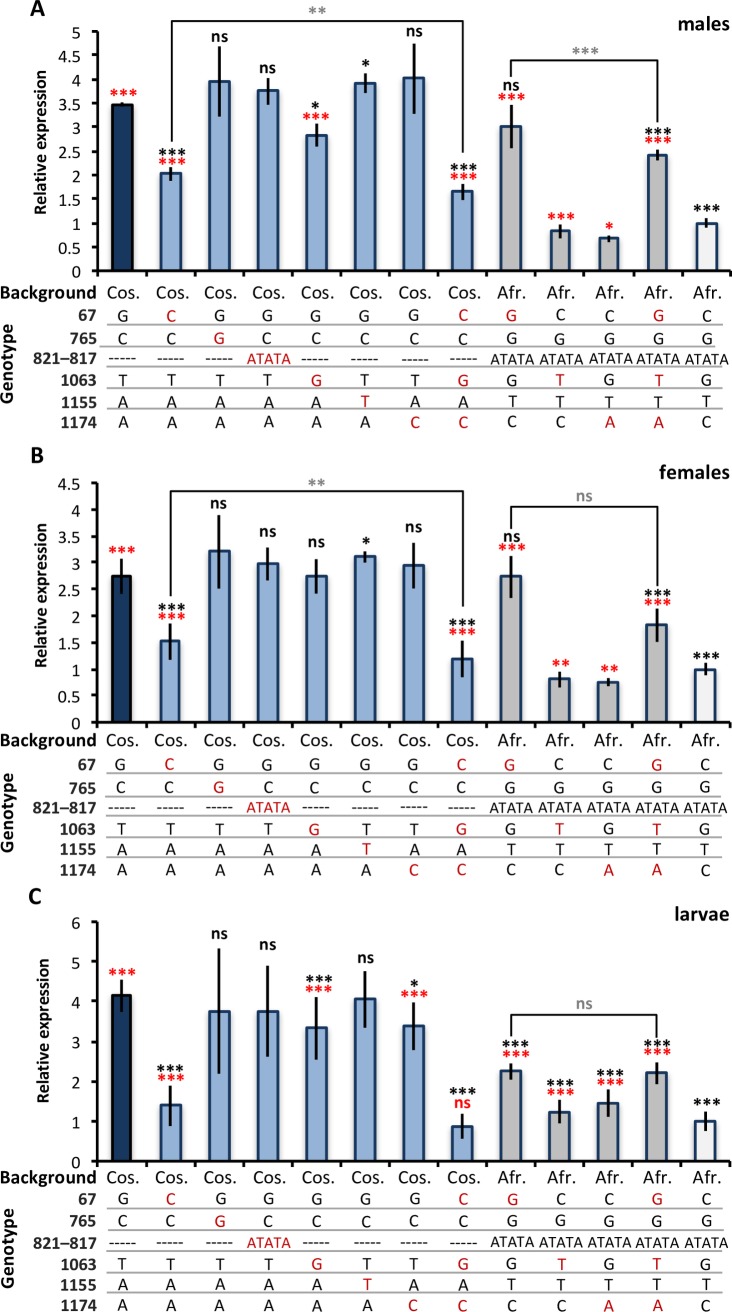
Transgenic reporter gene expression.Reporter gene expression in (A) males, (B) females, and (C) larvae (N = 4–8 per strain and sex or stage). Expression of the LacZ reporter gene was measured with a β-galactosidase enzymatic assay. Blue bars indicate expression driven by a wild-type cosmopolitan (Cos.) enhancer, while white bars show expression driven by a wild-type sub-Saharan African (Afr.) enhancer. Light blue bars indicate expression driven by the enhancer after mutations were introduced into a cosmopolitan background. Dark gray bars show expression driven by the enhancer after mutations were introduced in a sub-Saharan African background. “Genotype” indicates the nucleotides at positions 1174, 1155, 1063, 821–817, 765, and 67 before the CG9509 start codon, respectively. Mutated sites are shown in red. Underlying data can be found in S1 Data. Significance was assessed using a t test, and a Bonferroni multiple test correction was applied. Significance is represented by black asterisks for comparisons to the original cosmopolitan enhancer, red asterisks for the original sub-Saharan enhancer, and gray asterisks for comparisons between mutated enhancers. ns, not significant; *P < 0.05, **P < 0.01, ***P < 0.005.